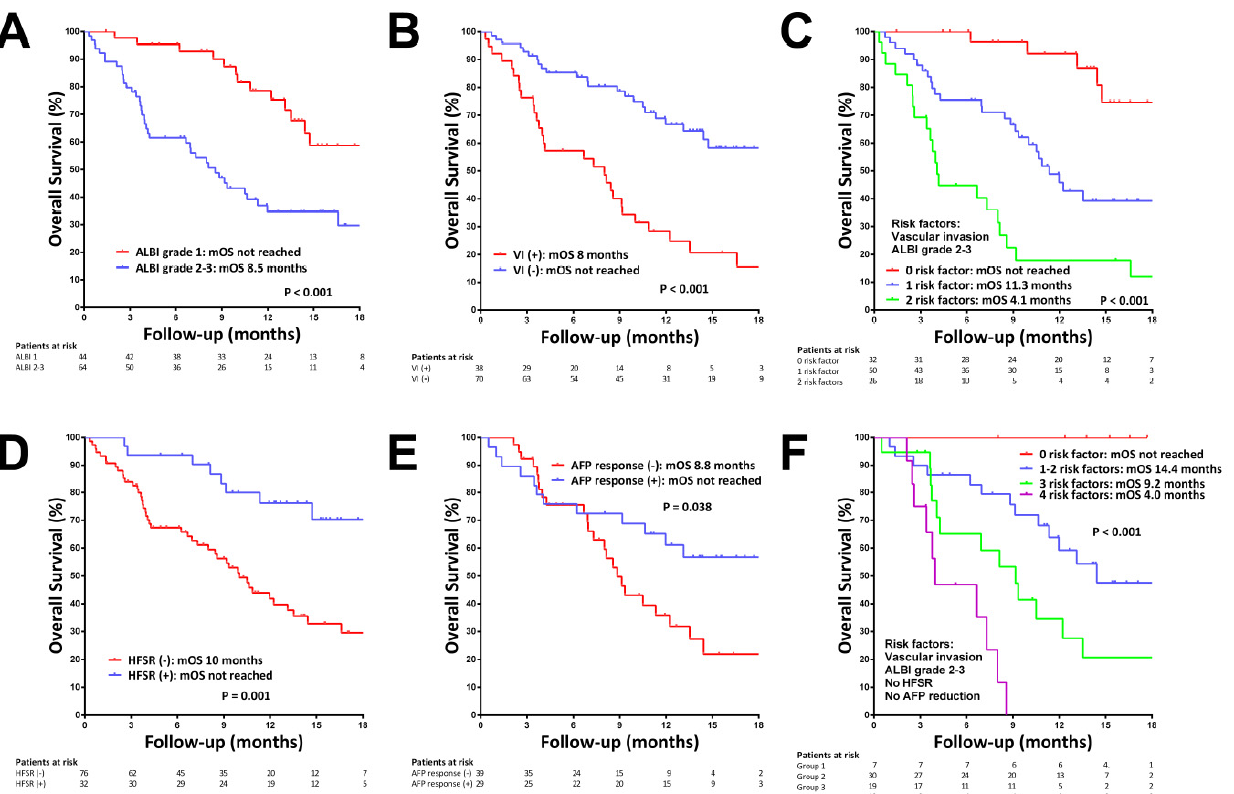
Figure 2. Kaplan–Meier curves for overall survival (OS) in patients with HCC receiving regorafenib treatment. ( A ) OS stratified by ALBI grade. ( B ) OS stratified by the status of portal vein invasion. ( C ) OS stratified by the number of baseline survival risk factors. ( D ) OS in patients with and without hand-foot skin reaction (HFSR). ( E ) OS in patients with and without early AFP response. ( F ) OS stratified by the number of baseline and on-treatment survival risk factors.